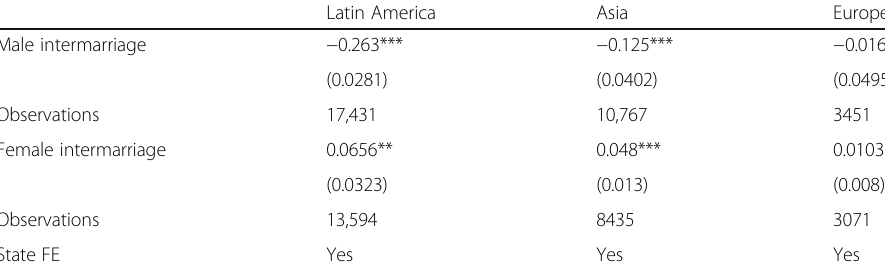
Table 7 Effects of intermarriage on household specialization: by immigrant place of origin Latin America Asia Europe Male intermarriage − 0.263*** − 0.125*** − 0.0160 (0.0281) (0.0402) (0.0495) Observations 17,431 10,767 3451 Female intermarriage 0.0656** (0.0323) (0.013) (0.008)